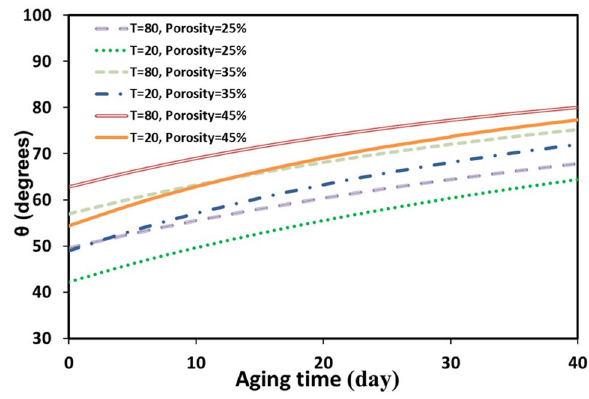
Fig. 11 Relationship between the aging time and calculated con- tact angle at porosities of 25%, 35% and 45% and displacement temperatures of 20 ºC and 80 ºC for the Rørdal